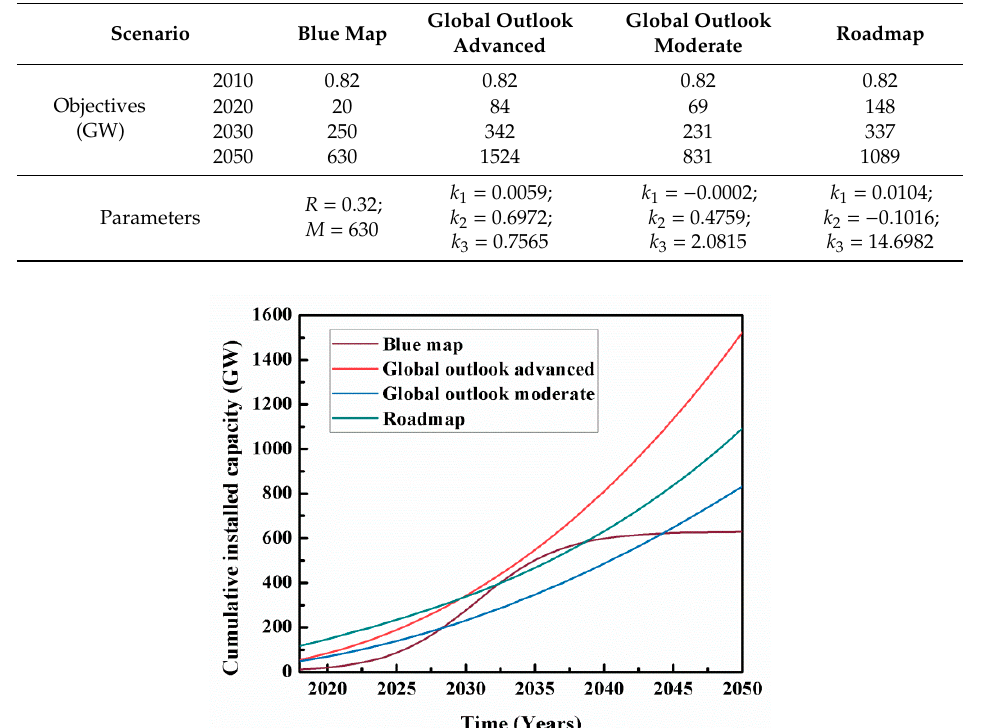
Figure 2. Fitting curves about cumulative installed capacity of CSP systems for four IEA scenarios in the years of 2018–2050.